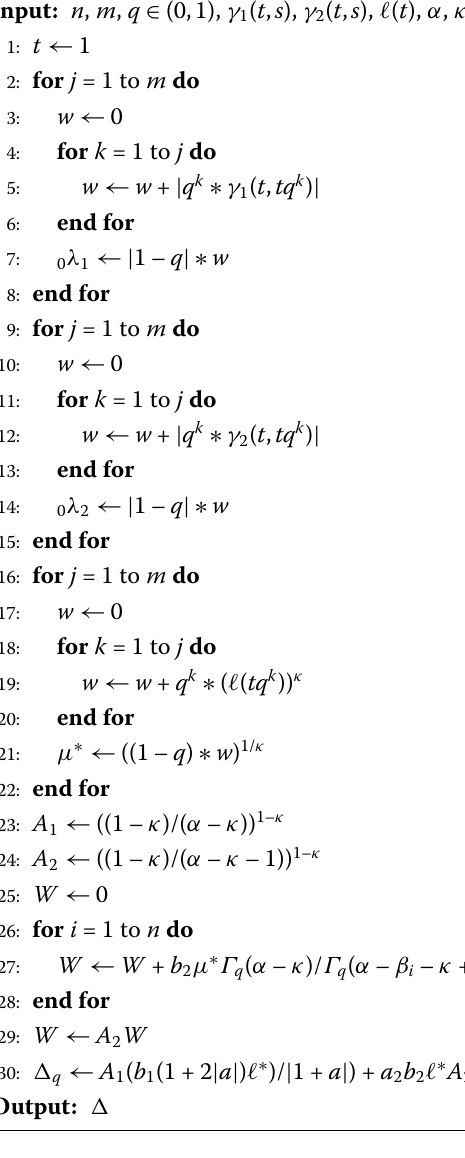
Algorithm 6 The proposed method for calculation of